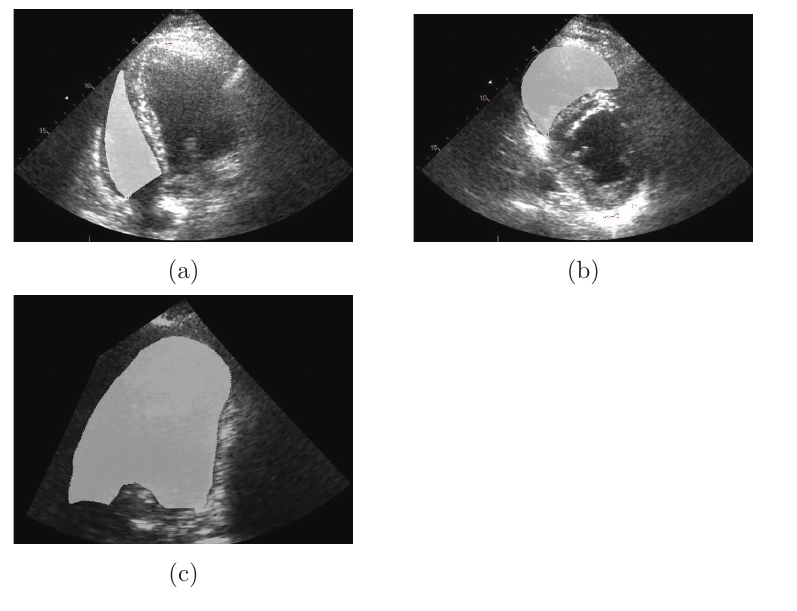
Figure 1. Regions of critical contours in four-chamber plane (a), transverse (short-axis) plane (b), and lateral plane (c) in the echocardiography images. 2. Planes should form a system of coordinate axes for the ventricle.